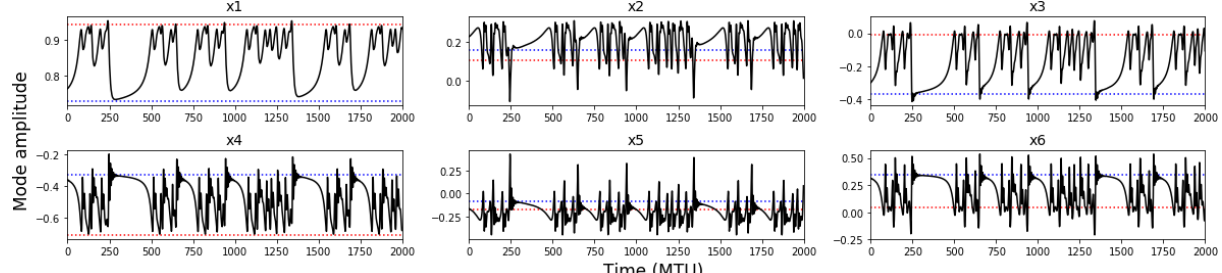
Figure 2. A 2000MTU integration of the CdV79 system, showing the evolution of each mode amplitude. The dynamics are chaotic but weakly so, showing clear quasi-periodic behaviour. Two regimes of behaviour can be seen: fast chaotic oscillations, divided by periods of slow evolution with irregular duration. The mode values at the blocked and zonal fixed points are shown with dashed blue and red